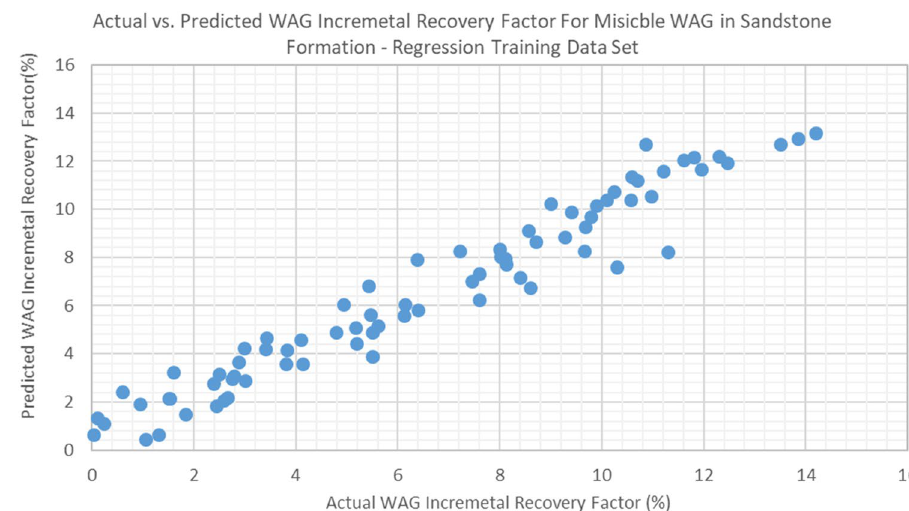
Fig. 6 Regression WAG incremental recovery factor prediction model training results for miscible WAG in sandstone